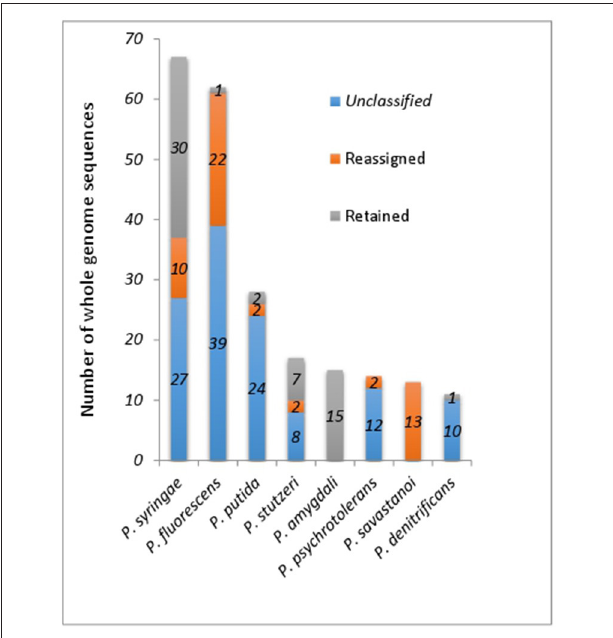
FIGURE 2 | Proportion of retained, reassigned and unclassified whole genome sequences within 8 most common Pseudomonas species excluding P. aeruginosa